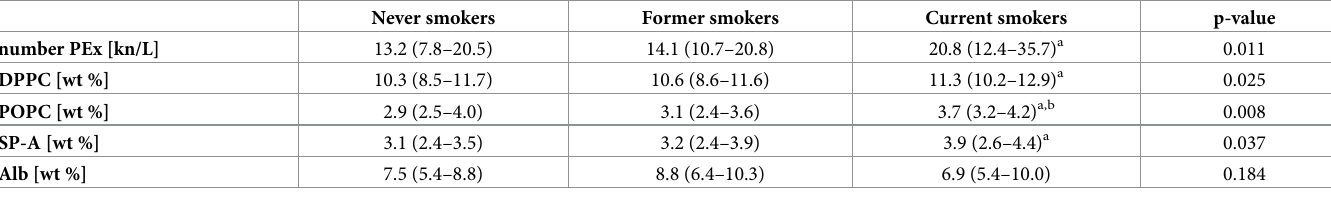
Table 2. PEx-variables in study population, subdivided according to smoking